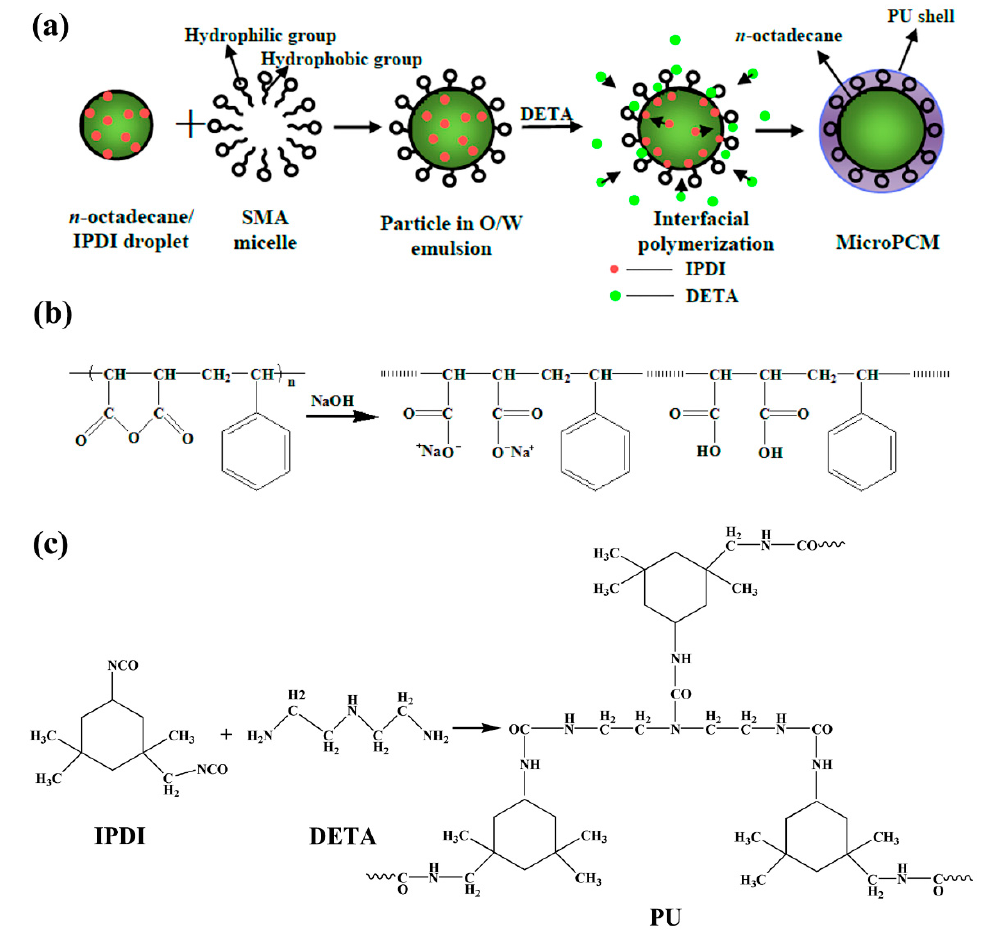
Figure 1. Schematic formation of the microencapsulated n -octadecane with the PU shell via interfacial polymerization. ( a ) Synthesis process of the microcapsules, ( b ) molecular structure of SMA and its hydrolyzed form, and ( c ) the polymerization reaction of PU shell.